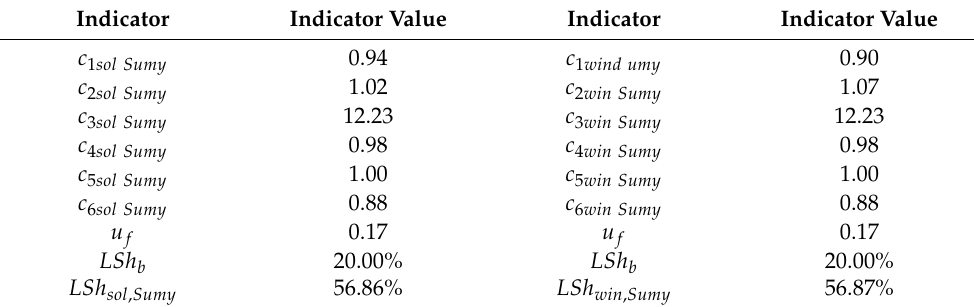
Table 8. Calculation of interest-free loan share in the total investment costs per 1 MW of installed capacity for home solar photovoltaic and wind power plants located in the Sumy region, Ukraine (calculated by the